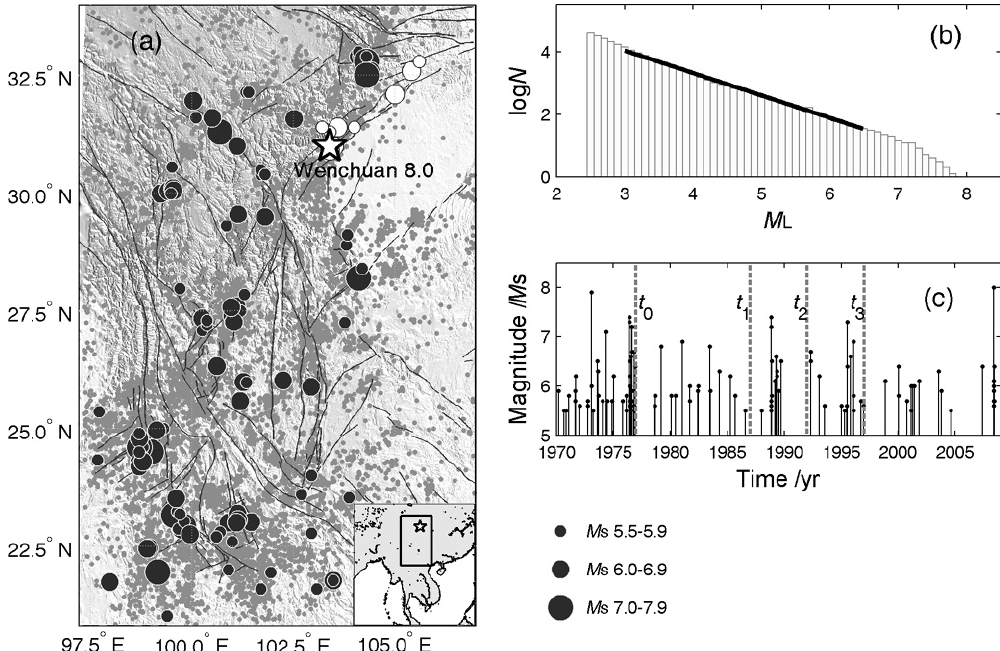
Fig. 1. (a) Sichuan-Yunnan region, with earthquakes larger than M S 5.5 since 1970 shown by black dots. Tectonic faults are shown by gray lines. Star and circles indicate the epicenters of the 2008 Wenchuan mainshock and its aftershocks, respectively. Gray dots show earthquakes from 1970 with a magnitude larger than M L 3.0. To the bottom right is the indexing figure showing the region under study. (b) Frequency-magnitude distribution of the earthquake catalogue. (c) Temporal distribution of earthquakes, with the vertical dash lines to the right representing t 1 the starting time of the “anomaly identifying window”, t 2 the ending time of the “anomaly identifying window” and the starting time of the “forecast window”, and t 3 the ending time of the “forecast window”. For the “sliding window” in this case, the catalogue for PI calculation is selected to start from t 0